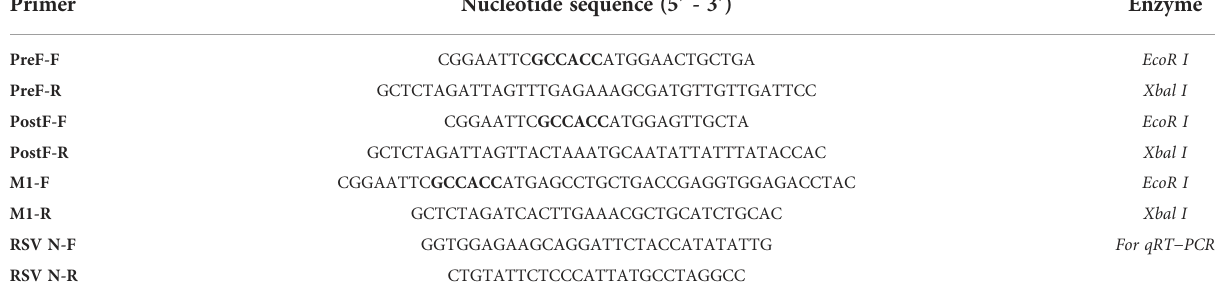
Underlined sequences represent restriction enzyme sites. Bolded regions indicate Kozak coding